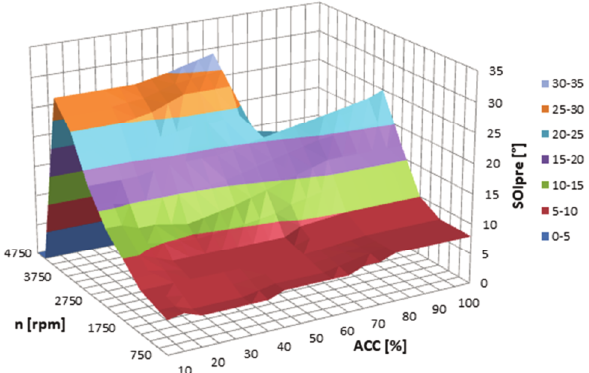
Fig. 10. Visual representation of the injection advance angle control algo- rithm for the Pre